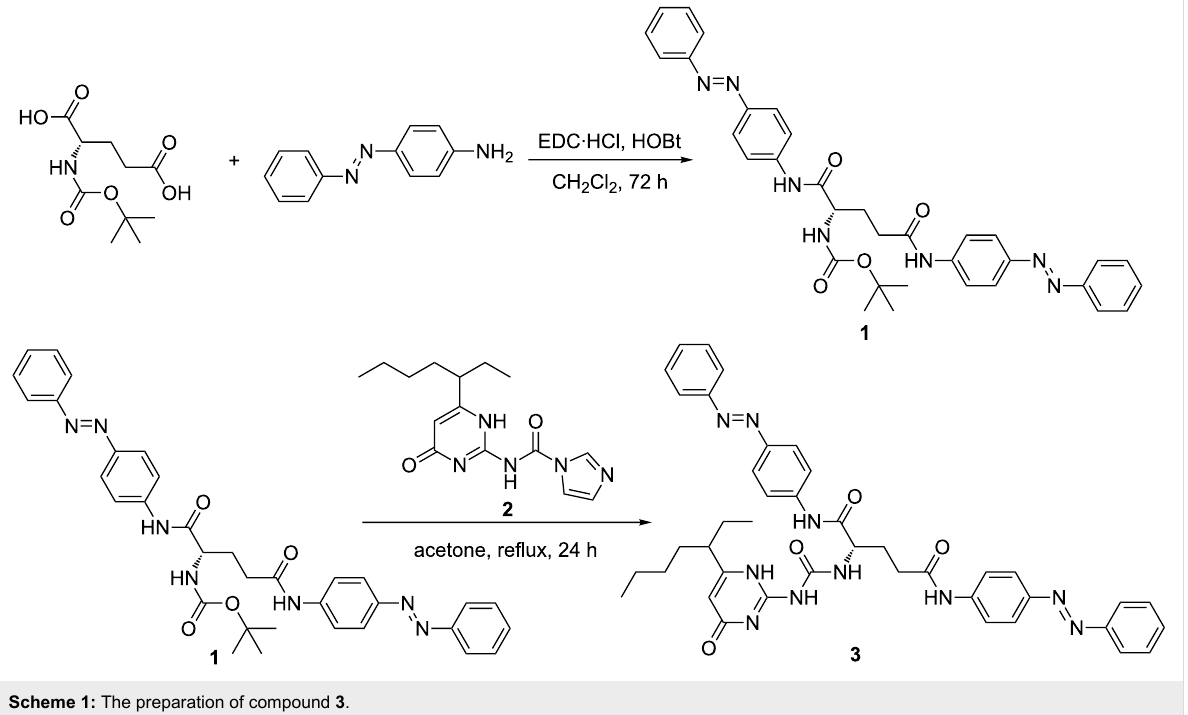
Scheme 1: The preparation of compound 3